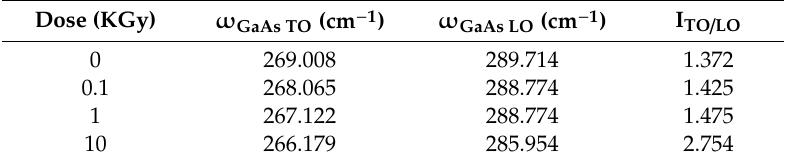
Table 2. The transverse-optical phonon frequency ( ω GaAs TO ) and longitudinal-optical phonon frequency ( ω GaAs LO ) of Si-doped GaAs under 0, 0.1, 1 and 10 KGy γ -radiation. The I TO / LO is the phonon intensity ratio of transverse-optical phonon and longitudinal-optical phonon. Dose (KGy) ω GaAs TO (cm − 1 )